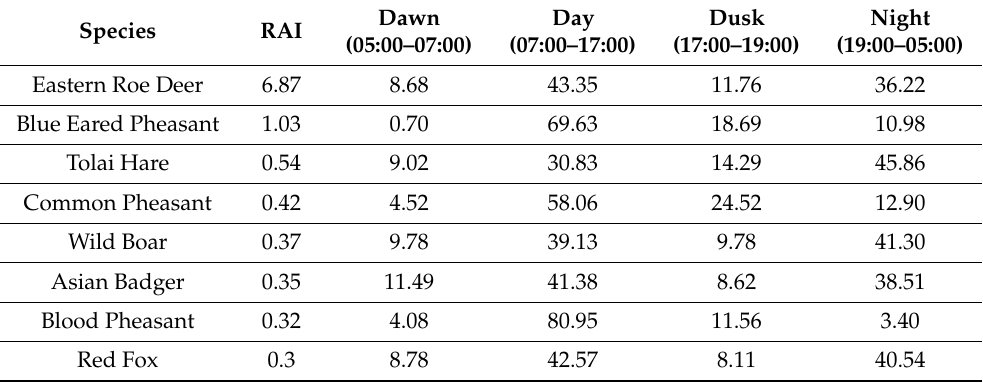
Table 1. Percentage of independent events of eight species of animals in four different time periods.